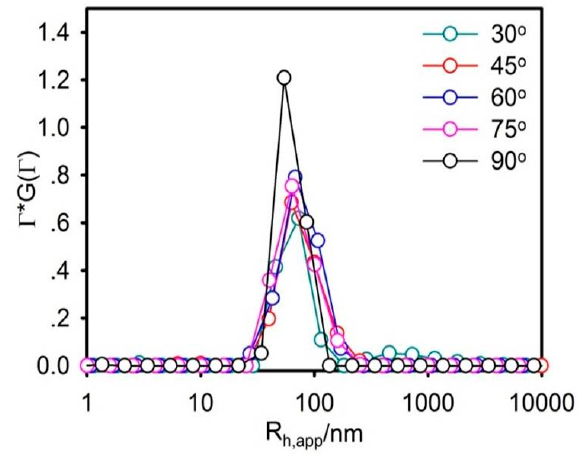
Figure 1. Size distribution of deoxyschizandrin and its liposome (DS-lipo). ρ p/l = 1.0. Temperature = 37 °C.